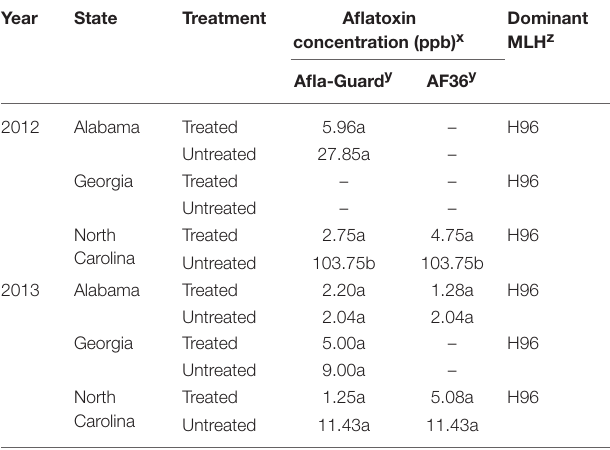
TABLE 8 | Aflatoxin concentration in harvested grain and dominant multilocus haplotypes (MLHs) of Aspergillus flavus in soil from fields in the southeastern United States treated with Afla-Guard and AF36 biocontrol